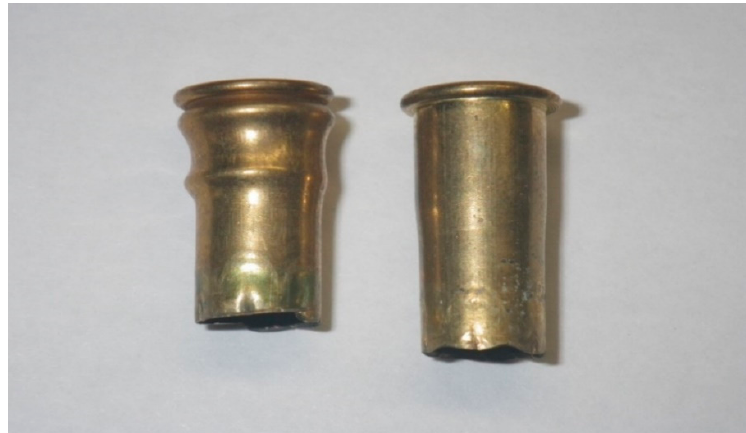
Figure 17. Deviation of cases fired in the same device. Right hand case displaying rim end expansion as expected to seal the case within the breech; left hand case showing deformity and signs of having moved backward on firing.